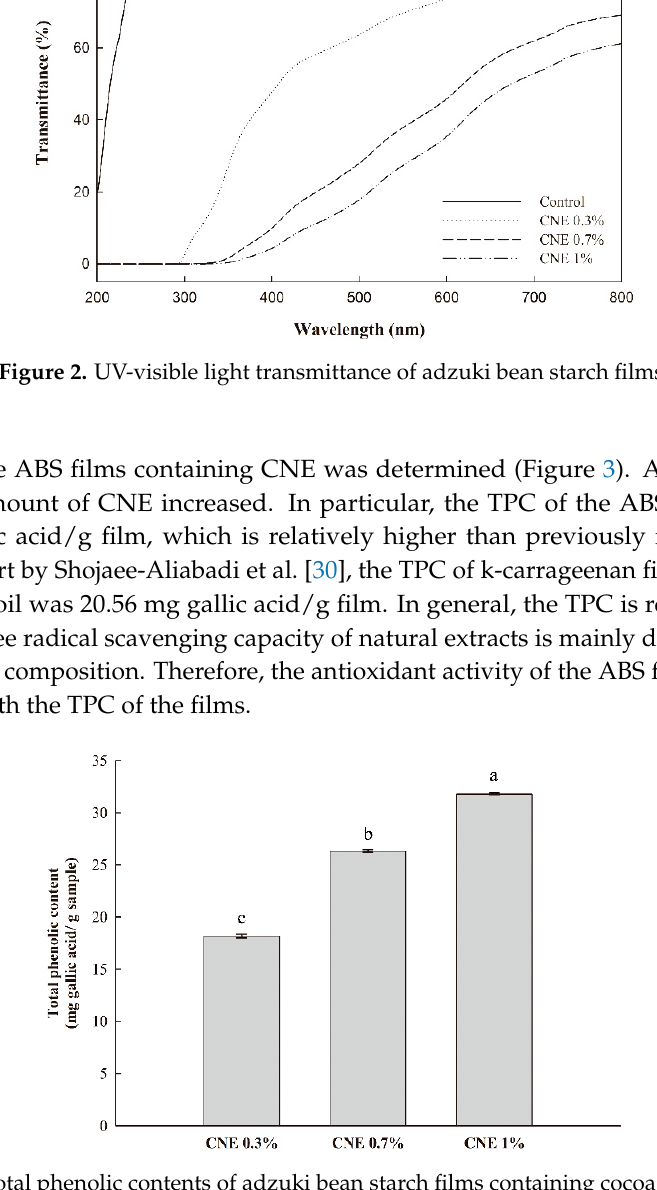
Figure 3. Total phenolic contents of adzuki bean starch films containing cocoa nibs extract.